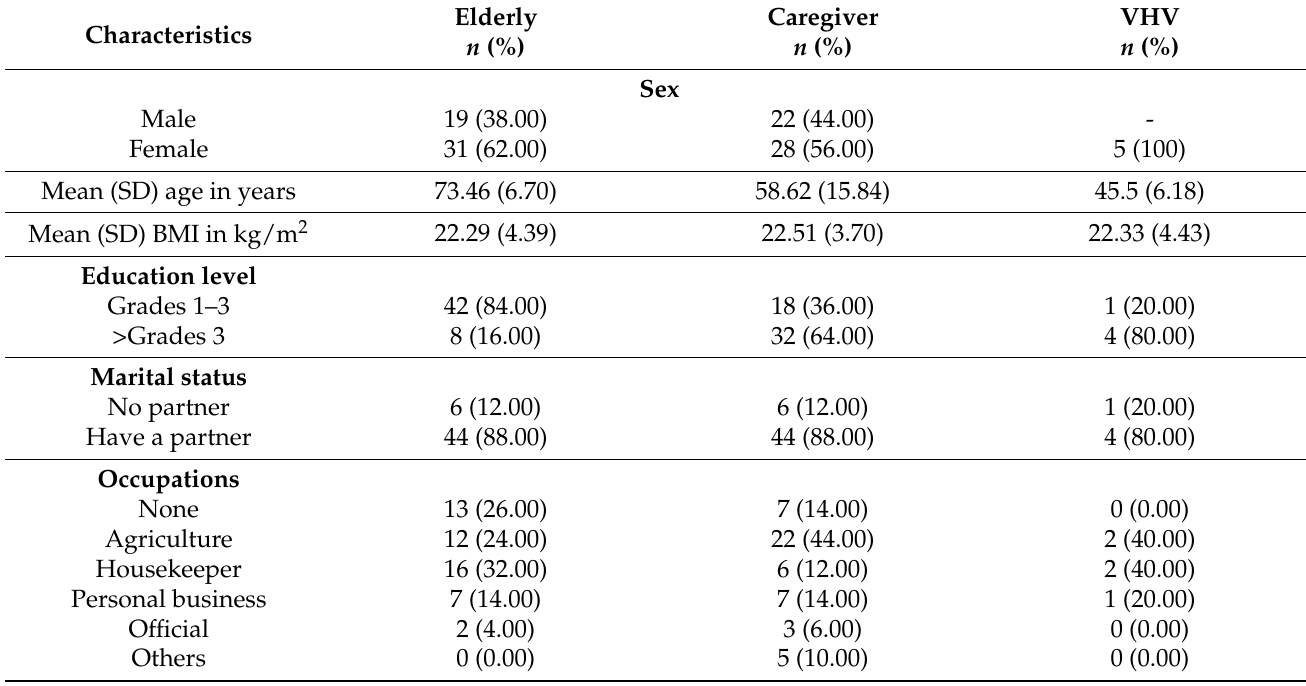
Table 2. Demographic characteristics of participants; elderly ( n = 50), caregiver ( n = 50), and VHV ( n =